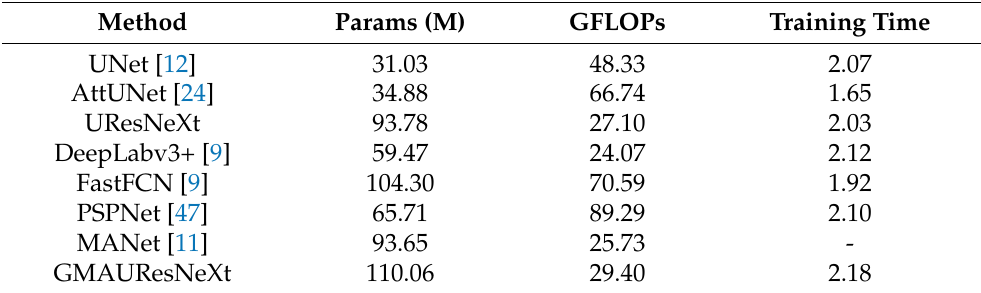
Table 4. The comparison of trainable parameters, computational complexity, and training time (hours) on the GID dataset. ‘M’ represents million, ‘GFLOPs’ represents giga floating-point operations. The shape of the input is 3 × 256 × 256.